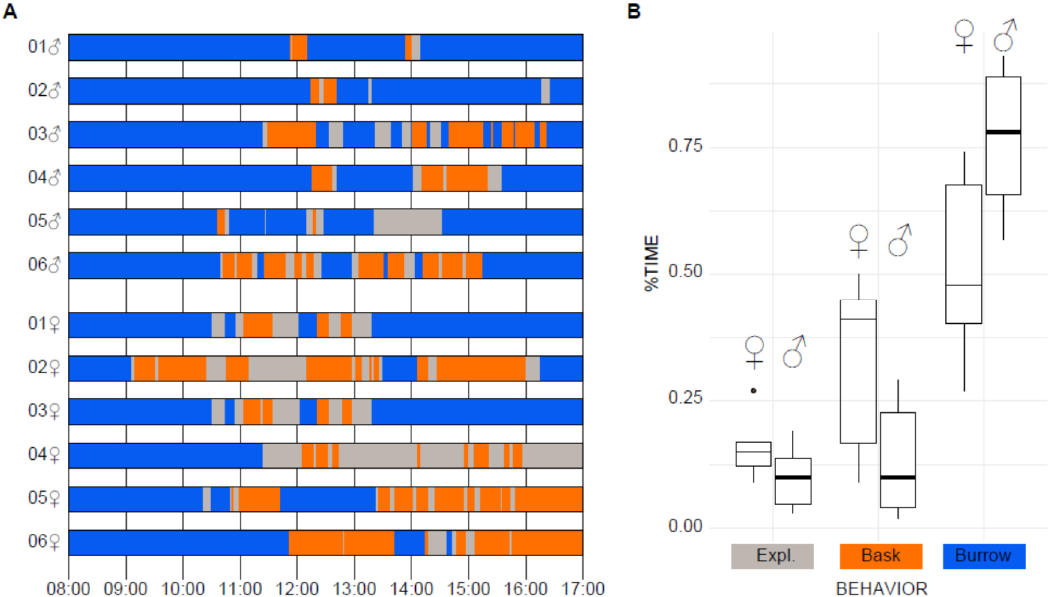
Figure 1. Exploratory (Expl.) behaviors in isolated lizards. ( A ) Scheme with the Distribution of Exploring (Gray), basking (Orange) and burrowing (Blue) behaviors across 9 h of observation for 12 individuals, 6 males and 6 females. ( B ) Boxplot for the percentage of time allocated to foraging (For), basking (Bask), and burrowing (Burrow) in males vs. females from Table 2. The boxes present a median line and standard deviation